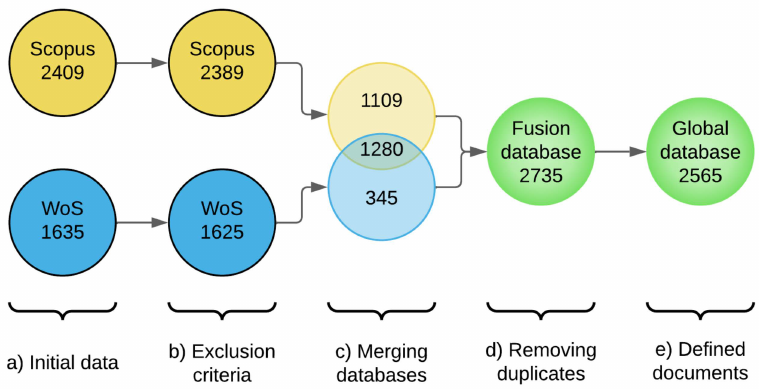
Figure 3. The systematic process of merging the databases with their respective number of documents.